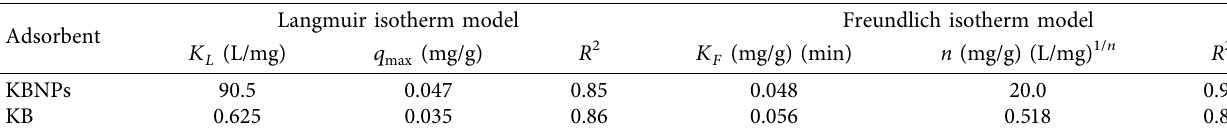
Table 3: Adsorption isotherm models’ parameters for adsorption of fluoride onto granules.